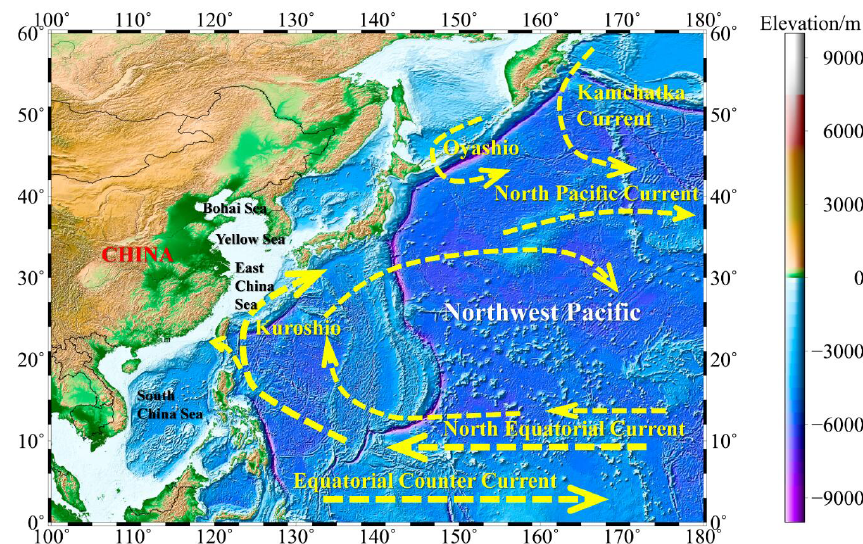
Figure 1. Bathymetric map of the northwest Pacific and ocean circulation.